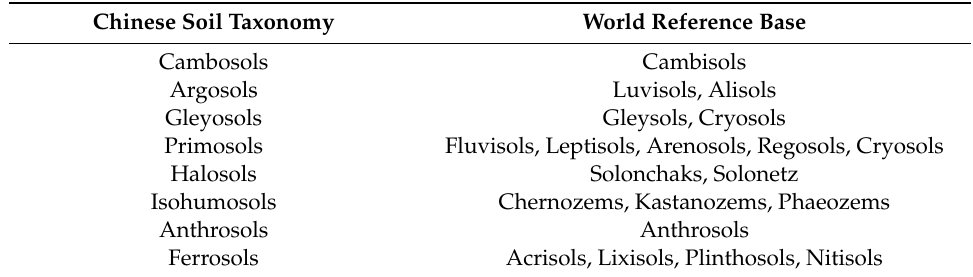
Table 2. Correlation between the Chinese Soil Taxonomy (CST) and the World Reference Base on the soil order level